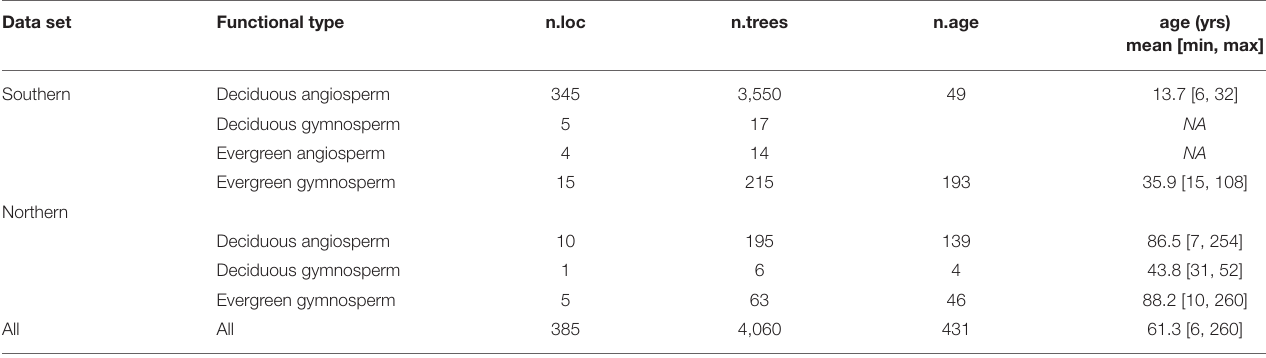
TABLE 1 | Summary of data sets in this study by functional type. Data